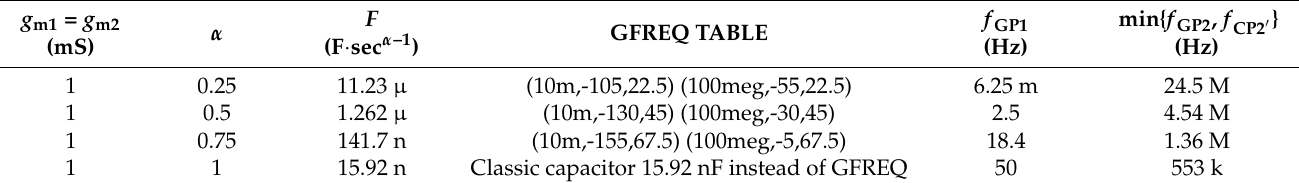
Table 1. First set of element parameters for simulation of the circuit in Figure 9 and its expected cut-off frequencies. g m1 = g m2